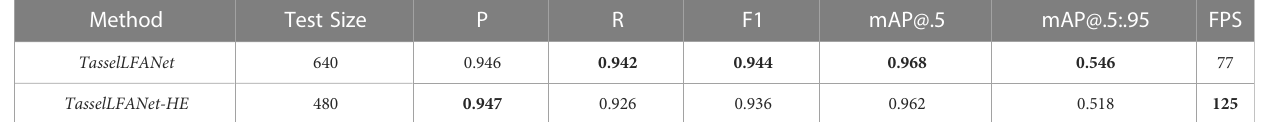
TABLE 5 Performance comparison between TasselLFANet-HE and TasselLFANet. Method